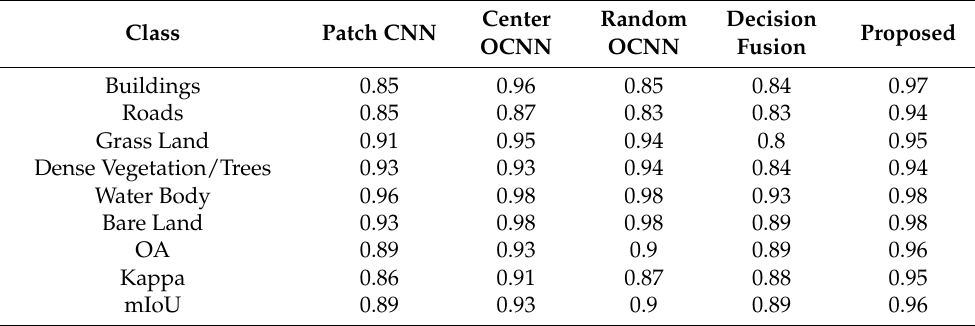
Table 5. Overall accuracy and per-class accuracies of the proposed and benchmark classification methods based on samples from the training area.